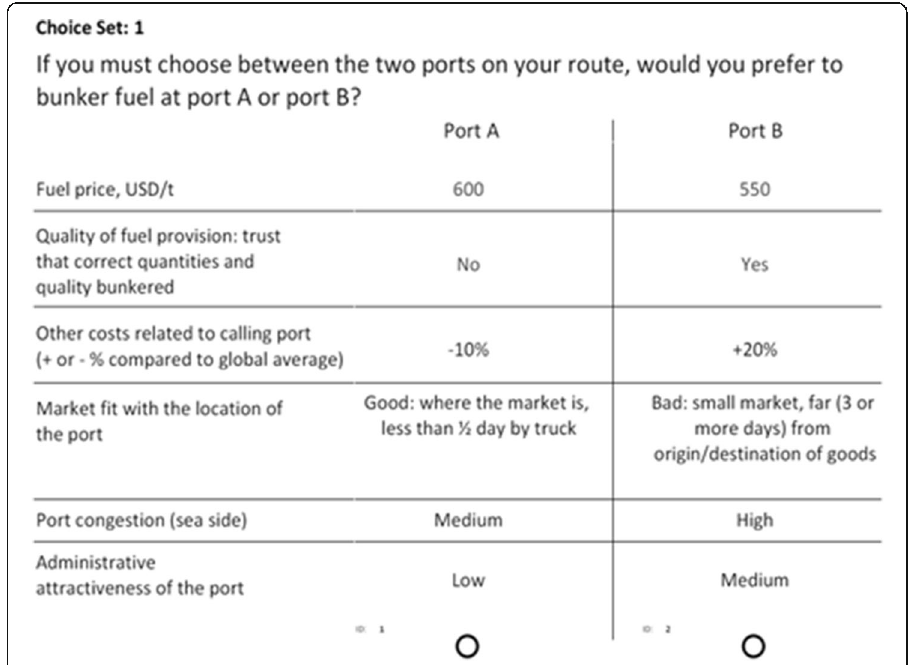
Fig. 1 Questionnaire for the discrete choice experiment. Source: own